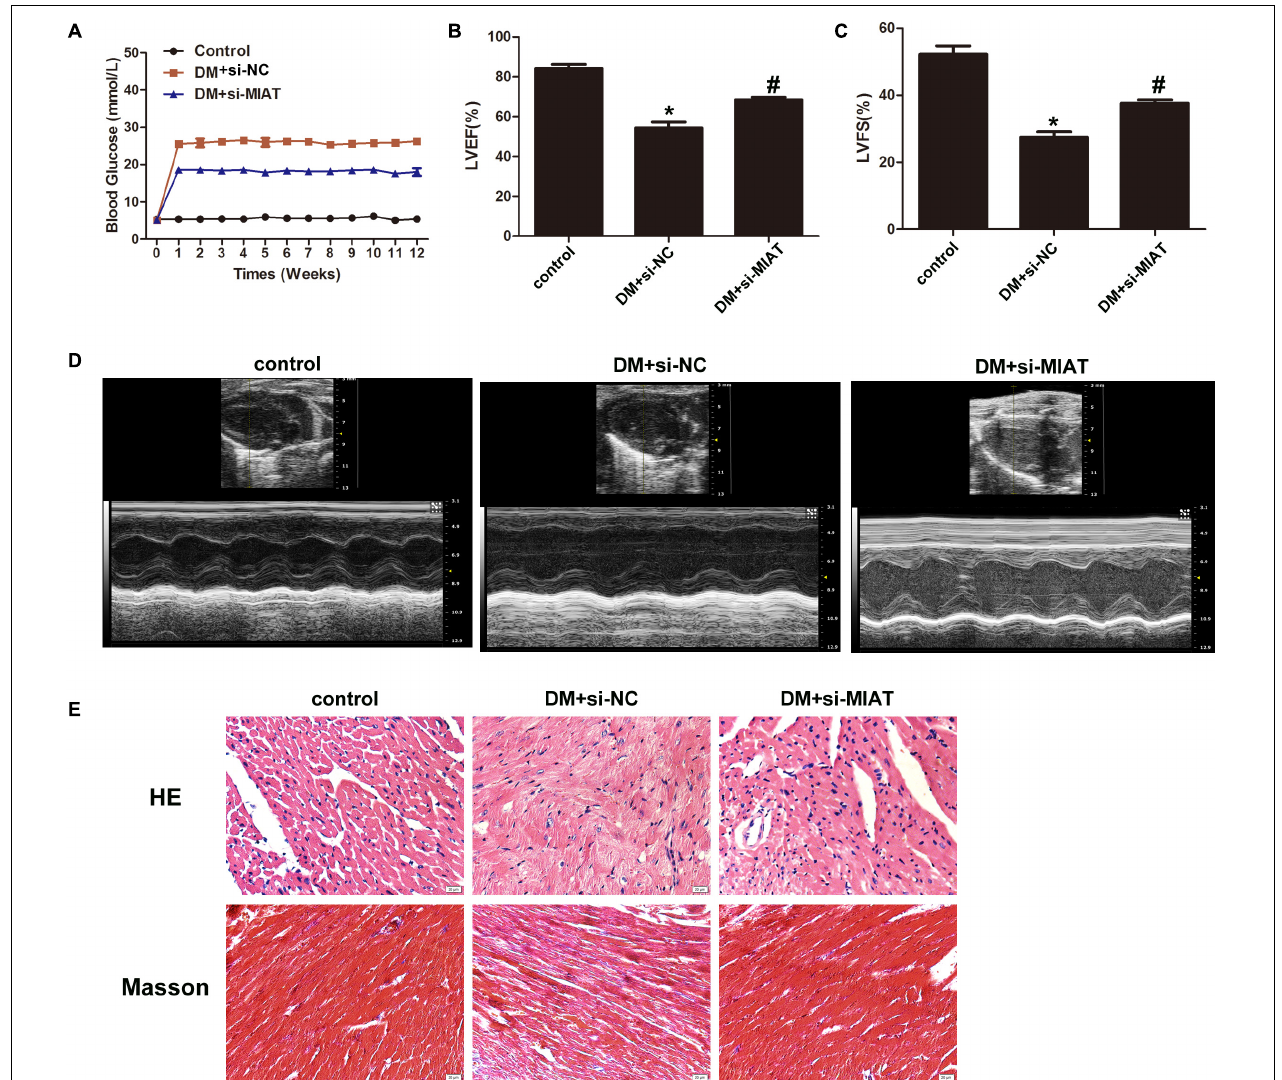
FIGURE 5 | Knockdown of MIAT improves cardiac ejection fraction. (A) FBG was tested once a week until 3 month. The FBG curves were plotted among three groups as indicated ( n = 5 per group). (B,C) LVEF% and LVFS% were measured by echocardiography, and the values were plotted as indicated ( n = 5 per group). * p < 0.05, # p < 0.01. (D) systolic and diastolic function was evaluated by echocardiography. Representative images were demonstrated as indicated. (E) H&E and Masson staining of hearts harvested from control, DM and DM-siMIAT mice at the end of the experiment. Images were taken using the SPOT Insight camera and Nikon ECLIPSE E600 microscope at original magnification × 40. Scale bars, 20 µ